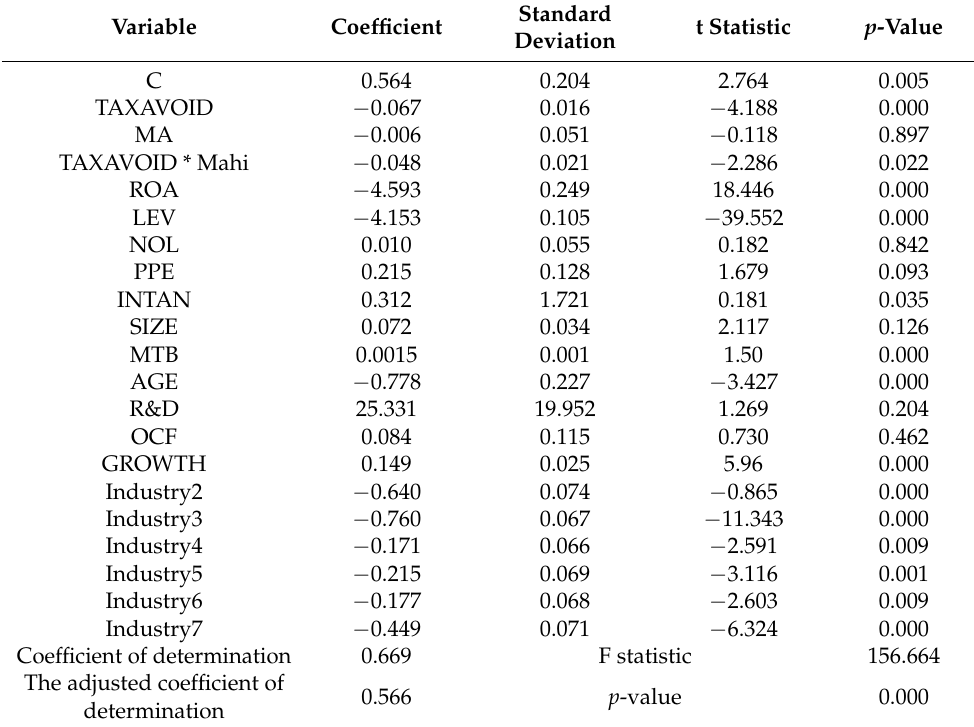
Table 8. The results of the estimation of second regression model coefficients using the fixed panel method.